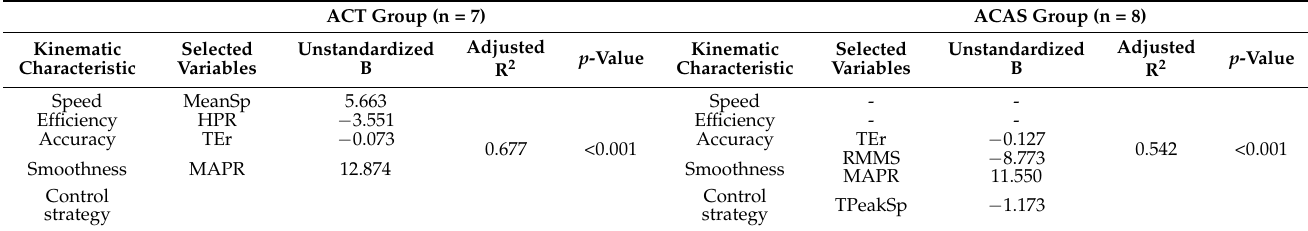
Table 7. Multivariable linear regression analysis of kinematic features for FMA-prox in the ACT and ACAS groups.